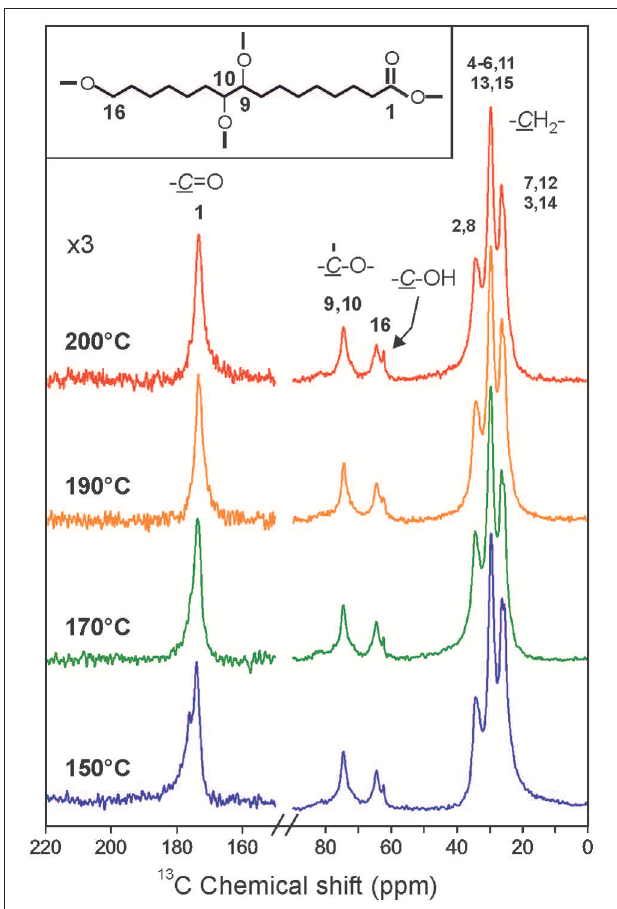
FIGURE 2 | 13 C solid-state NMR spectra of polyaleuritate prepared by melt-polycondensation in air at the indicated temperature for